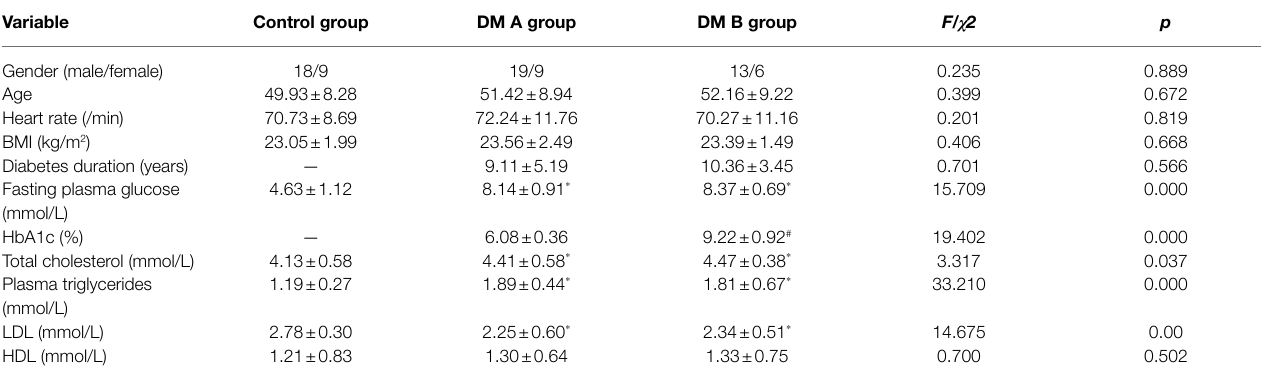
TABLE 1 | Basic information of the three groups. Variable